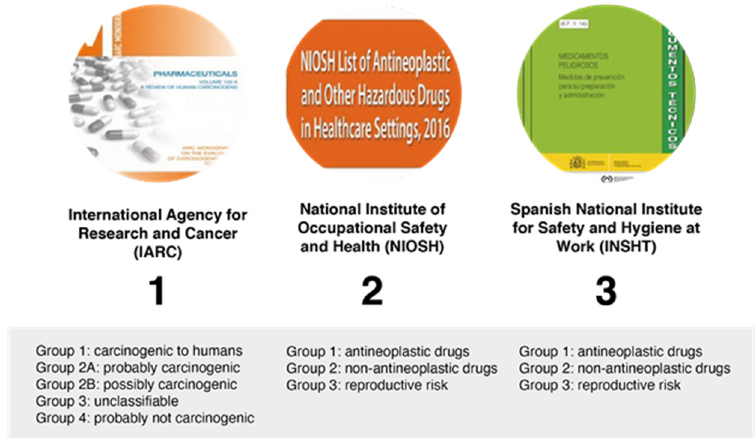
Figure 4. Classification of hazardous drugs by different organizations.